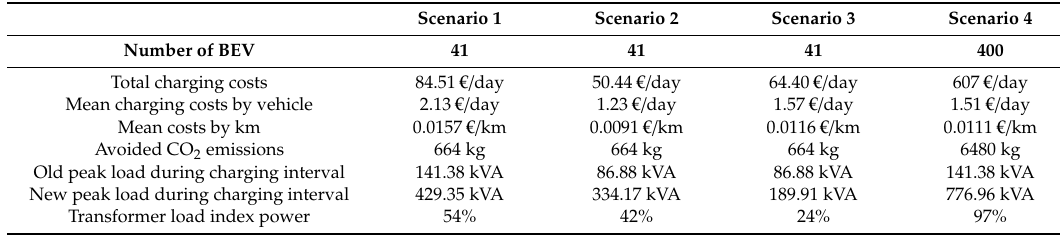
Table 7. Charging scenarios summary results.